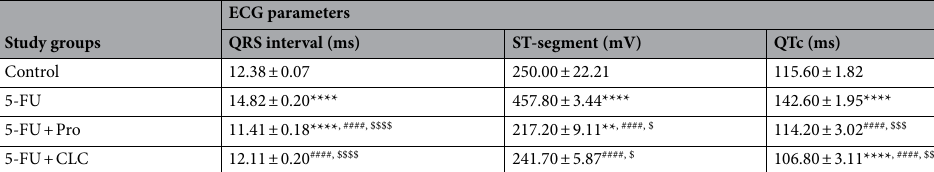
Table 2. Electrocardiogram parameters of study groups. Values are expressed as mean ± standard deviation (SD). Groups: Control, Normal saline; 5-FU, 5-FU 125 mg/kg; 5-FU + Pro, 5-FU 125 mg/kg + Propolis #### Indicate statistically significant difference compared to the 5-FU group (p < 0.0001). $ , $$$ , and $$$$ Indicate statistically significant difference between the treatment groups (p < 0.05, p < 0.001, and p < 0.0001,